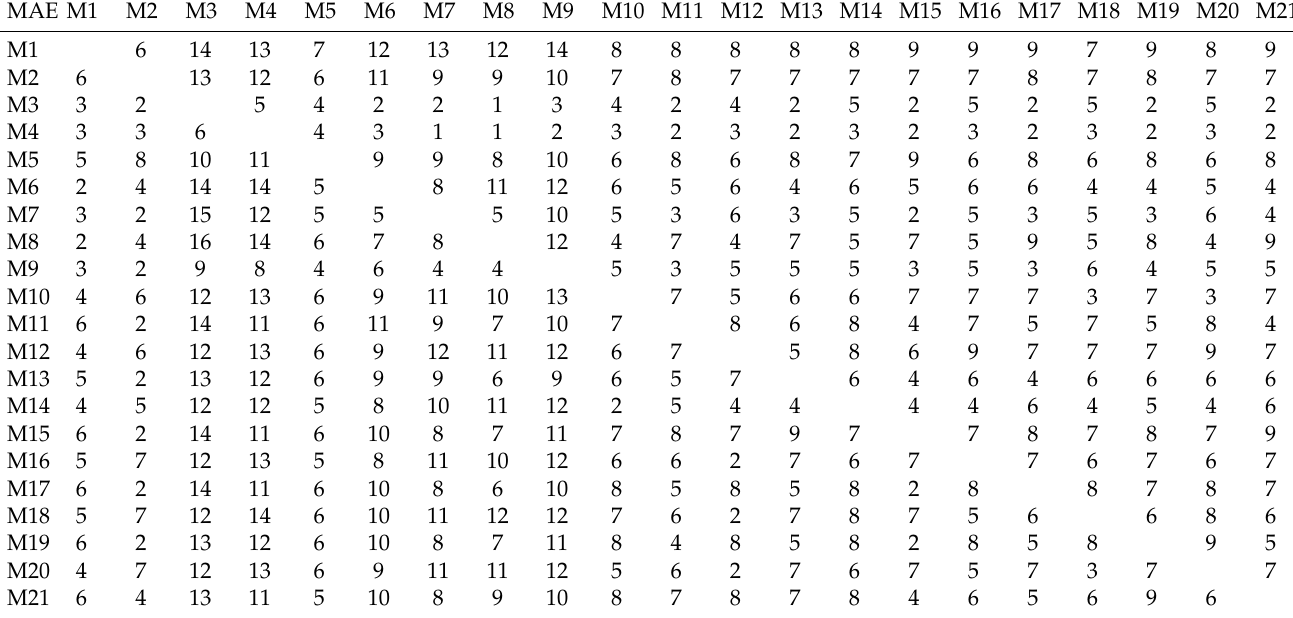
Table 18. MAE for DM test in out-of-sample tourism demand volatility forecasting.